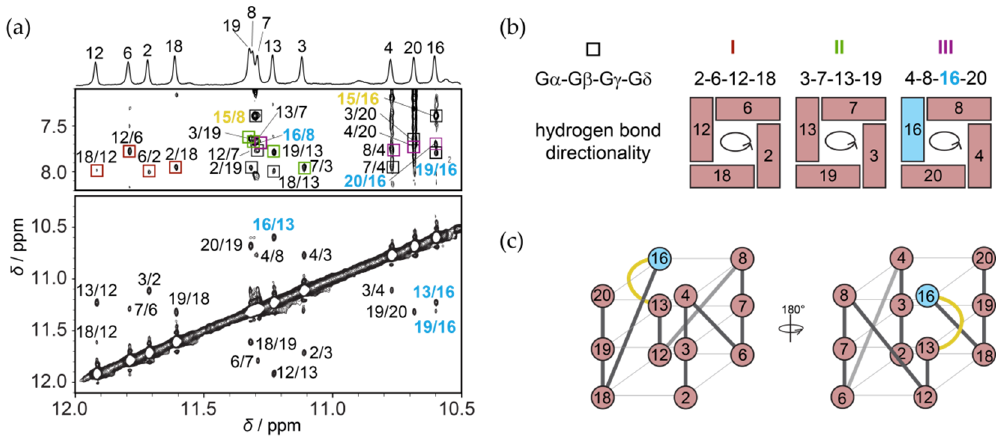
Figure 2. NMR spectral assignments and folding topology of RAN1*. ( a ) Imino region of assigned 1D 1 H NMR spectrum of RAN1* (top) and imino-aromatic and imino-imino regions of the corresponding 2D NOESY NMR spectrum (mixing time of 300 ms). Imino-H8 cross-peaks labeled with dark red, green, and violet rectangles correspond to intra-quartet connectivities within the G2•G6•G12•G18, G3•G7•G13•G19 and G4•G8•G16•G20 quartets, respectively. Cross-peaks labeled with black rectangles belong to imino-H8 NOE connectivities between neighboring G-quartets. All NOEs involving G16 are marked with light blue, while NOE contacts suggesting stacking of A15 with neighboring G-quartet are highlighted in yellow. ( b ) G-quartets I, II, and III with the corresponding donor-to-acceptor hydrogen bond directionalities. ( c ) Schematic presentations of G-quadruplex adopted by RAN1* with three propeller-type loops (grey) and a bulge (yellow). Residues in G-quartet core adopting anti and syn glycosidic conformations are colored salmon and light blue, respectively.